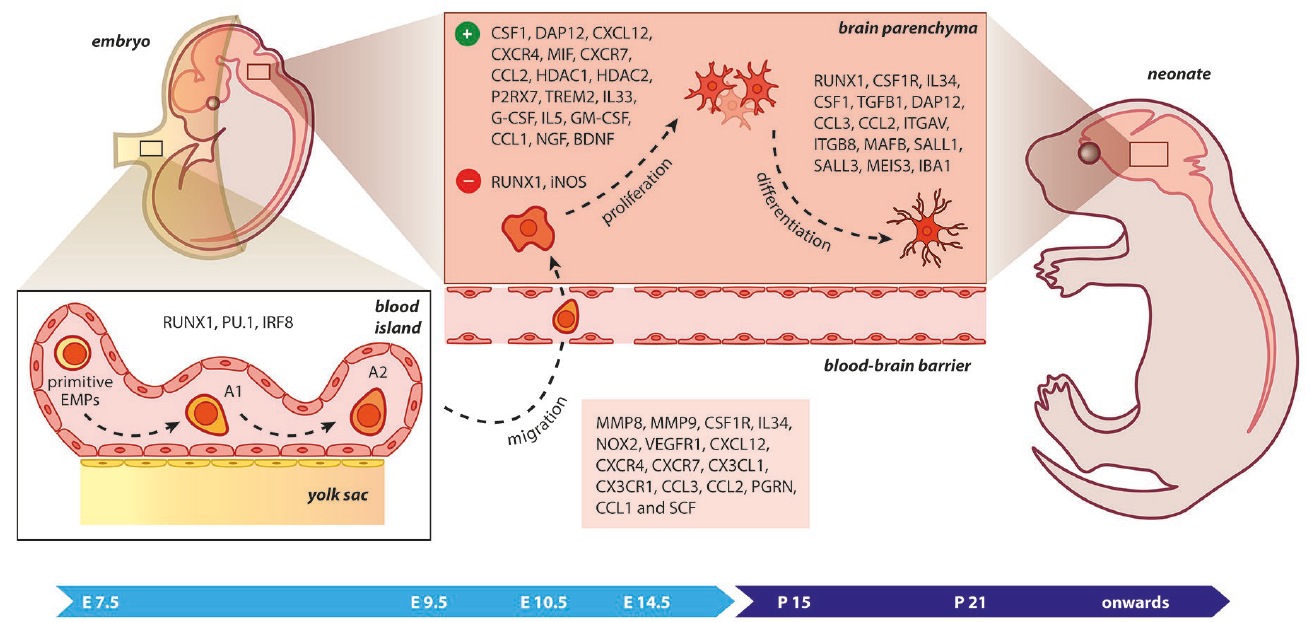
Figure 2. Microgliogenesis at a glance. The primitive erythro-myeloid progenitors (EMPs; early, c − MYB − independent, CSF − 1R + EMPs) arise from the yolk sac (YS) as early as embryonic day 7.5 (E7.5). These cells give rise to CD45 + c − kit lo CX 3 CR1 − immature (A1) cells that develop into CD45 + c − kit − CX 3 CR1 + (A2) cells. The early differentiation of microglial progenitors is regulated by the expression of RUNX1, PU.1, and IRF8. The invasion of progenitors into the neural tube begins at E9.5 through blood circulation and is followed by proliferation and terminal differentiation. As the blood–brain barrier becomes impermeable to small molecules at E14.5, the microglia invasion may be prevented. The transformation of immature microglia into ramified (mature form) occurs between the second and third postnatal weeks. The migration, proliferation, and terminal differentiation of microglia are also orchestrated from the depicted molecular cues. Light blue arrow timeline represents prenatal period, dark blue arrow timeline refers to postnatal days.